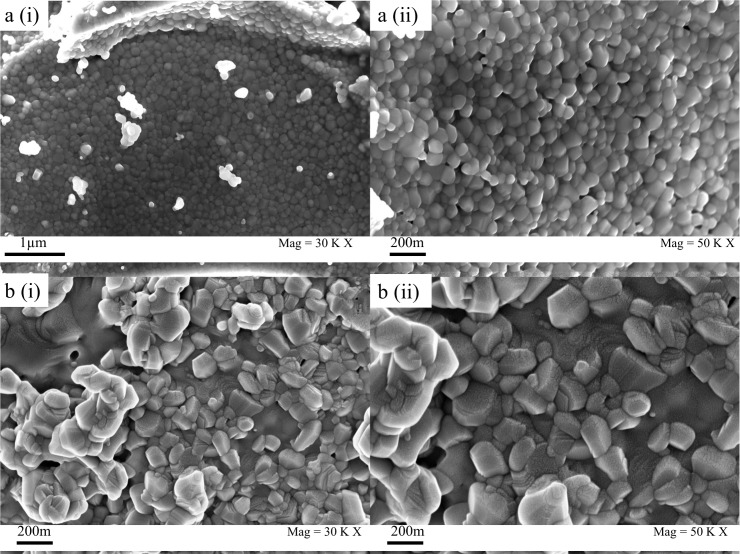
Morphological analysis of La3+ substituted Ni-Zn ferrite nanoparticle.FESEM micrographs of typical a) Ni-Zn ferrite (i) 30KX (ii) 50KX and b) Ni0.5Zn0.5LaxFe1-xO4 at (x = 0.02) (i) 30KX (ii) 50KX.